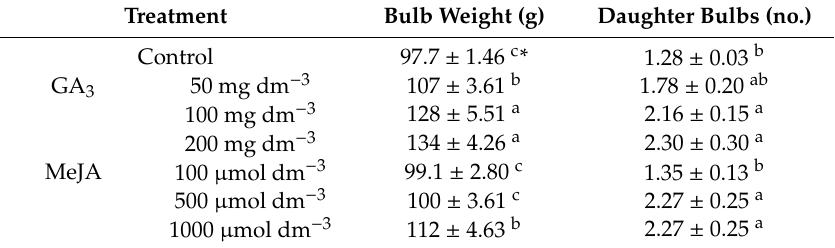
Table 3. E ff ects of GA 3 and MeJA on × Amarine tubergenii “Zwanenburg” bulb yield.